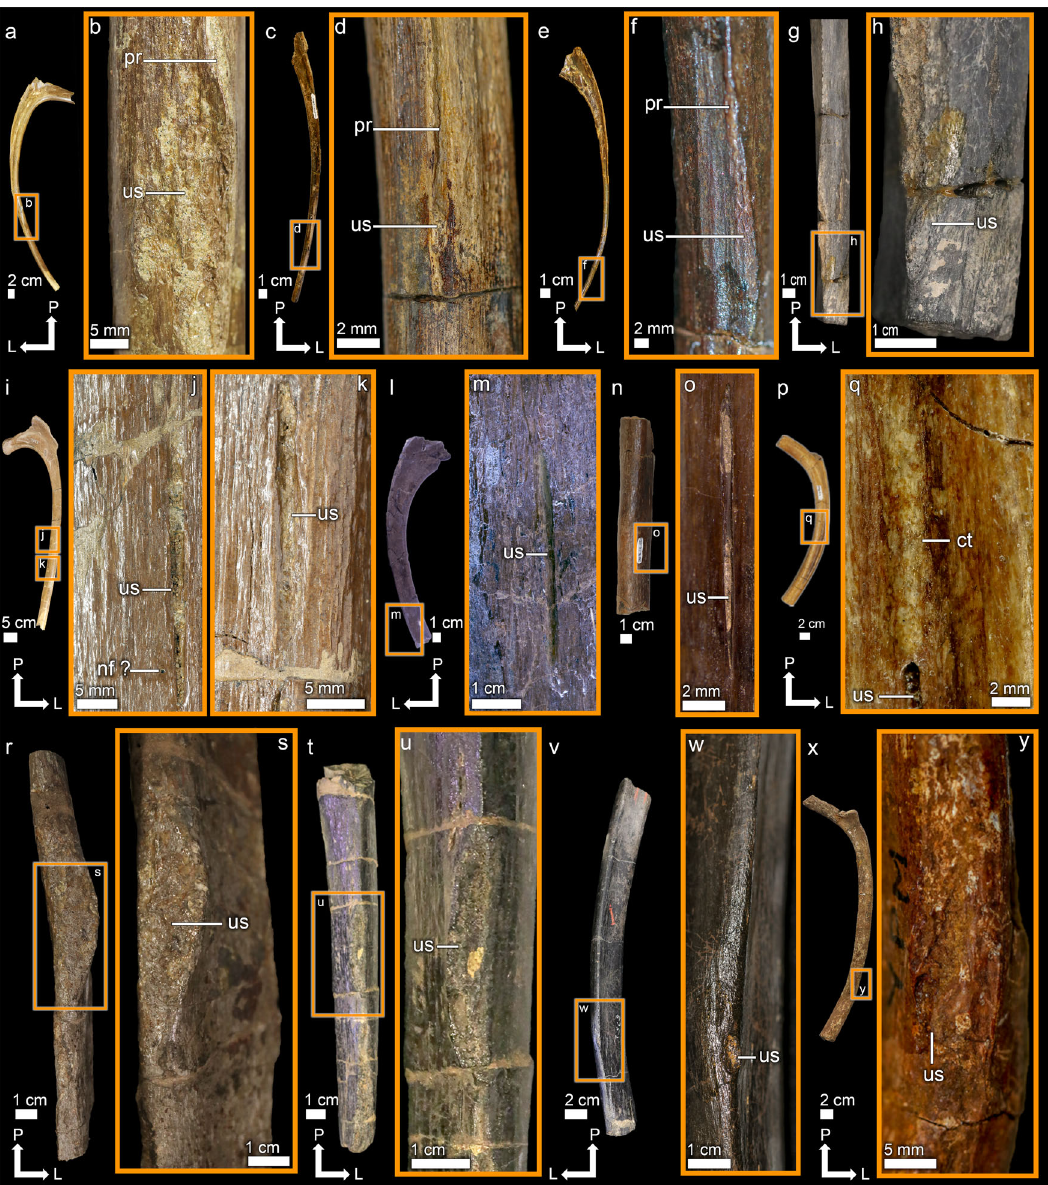
Fig. 2 Vertebral ribs with uncinate scars in fossil archosaurs. Left vertebral rib referred to Tyrannosauridae indet. (TMP 92.36.1231) ( a ), and close-up of uncinate scar in posterior view ( b ); right vertebral rib of juvenile individual referred to Tyrannosauridae indet. (TMP 94.12.960) ( c ), and close-up of uncinate scar in posterior view ( d ); right vertebral rib of the ornithomimisaurian theropod Struthiomimus altus (AMNH 5355) ( e ), and close-up of uncinate scar in posterior view ( f ); right vertebral rib of the sauropod Apatosaurus excelsus (YPM 1981) ( g ), and close-up of uncinate scar in posterior view ( h ); right vertebral rib of the hadrosaur Gryposaurus notabilis (AMNH 5350) ( i ), and close-up of uncinate scar in posterior view ( j , k ); left vertebral rib of the ceratopsid Pachyrhinosaurus lakustai (UALVP 57289) ( l ), and close-up of uncinate scar in posterior view ( m ); vertebral rib referred to ceratopsid Centrosaurus sp. (TMP 96.176.135) ( n ), and close-up of uncinate scar in posterior view ( o ); right vertebral rib referred to ceratopsid Centrosaurus sp. (TMP 82.19.41) ( p ), and close-up of uncinate scar in posterior view ( q ); vertebral rib of ankylosaur Sauropelta edwardsi (AMNH 3032) ( r ), and close-up of uncinate scar in posterior view ( s ); vertebral rib of the stegosaur Stegosaurus stenops (AMNH 650) ( t ), and close-up of uncinate scar in posterior view ( u ); left vertebral rib referred to stegosaur Stegosaurus sp. (AMNH 5752) ( v ), and close-up of uncinate scar in posterior view ( w ); pseudosuchian right vertebral rib referred to Phytosauria indet. (YPM 6649) in posteromedial view ( x ), and close-up of uncinate scar in posterior view ( y ). ct calci fi ed tissue, L lateral, nf? potential nutrient foramen, P proximal, pr proximal ridge, us uncinate